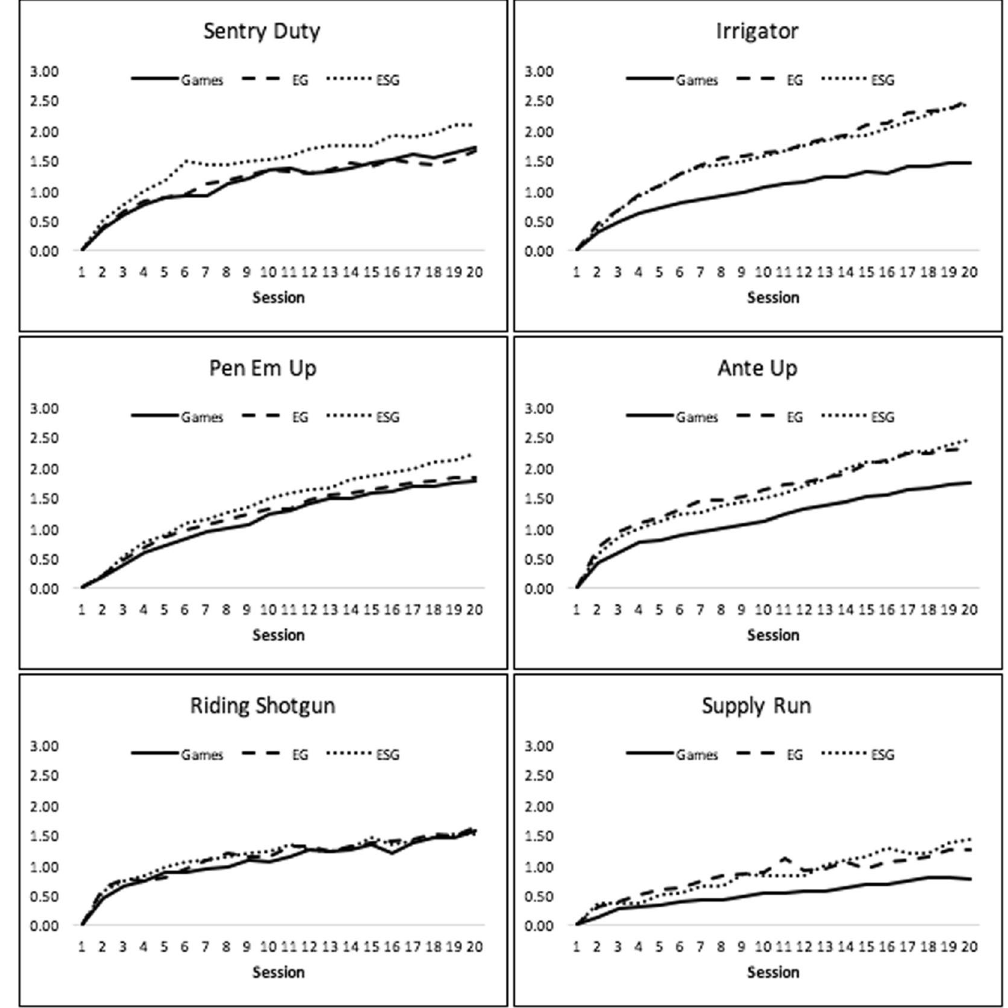
Figure 1. Enhanced Training Performance Over Time. Standardized improvement units are on y-axis. There was a significant group difference in terms of slope and area under the curve for all games except Riding Shotgun (alpha = 0.05). Games = computerized game training. EG = Exercise and computerized game training. ESG = Exercise, brain stimulation, and computerized game